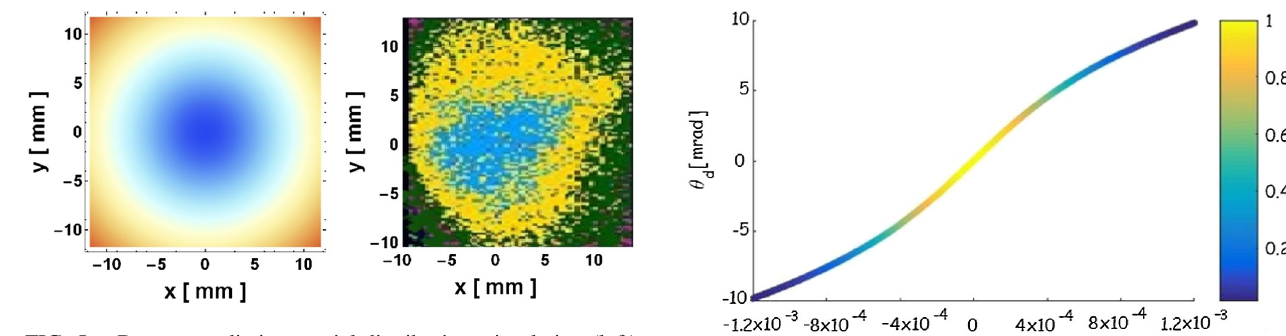
FIG. 5. Betatron radiation spatial distribution: simulation (left) and measurement (right). Measured divergence of the radiation beam θ meas β FIG. 7. Reconstructed trace-space density, corresponding to the contour line of the curve f r; θ d ð r Þ ; P ð r Þg , where P ð r Þ corre- sponds to the solid blue line of Fig. (2).